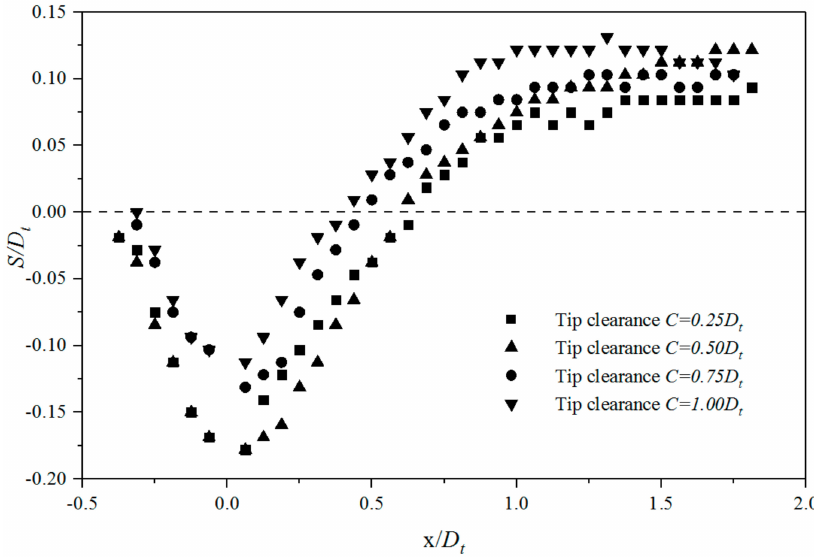
Figure 15. Scour profiles at di ff erent tip